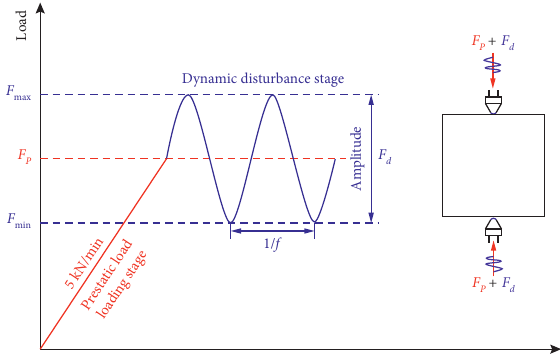
Figure 5: Point load test loading path of prestatically loaded marble subjected to low-frequency dynamic